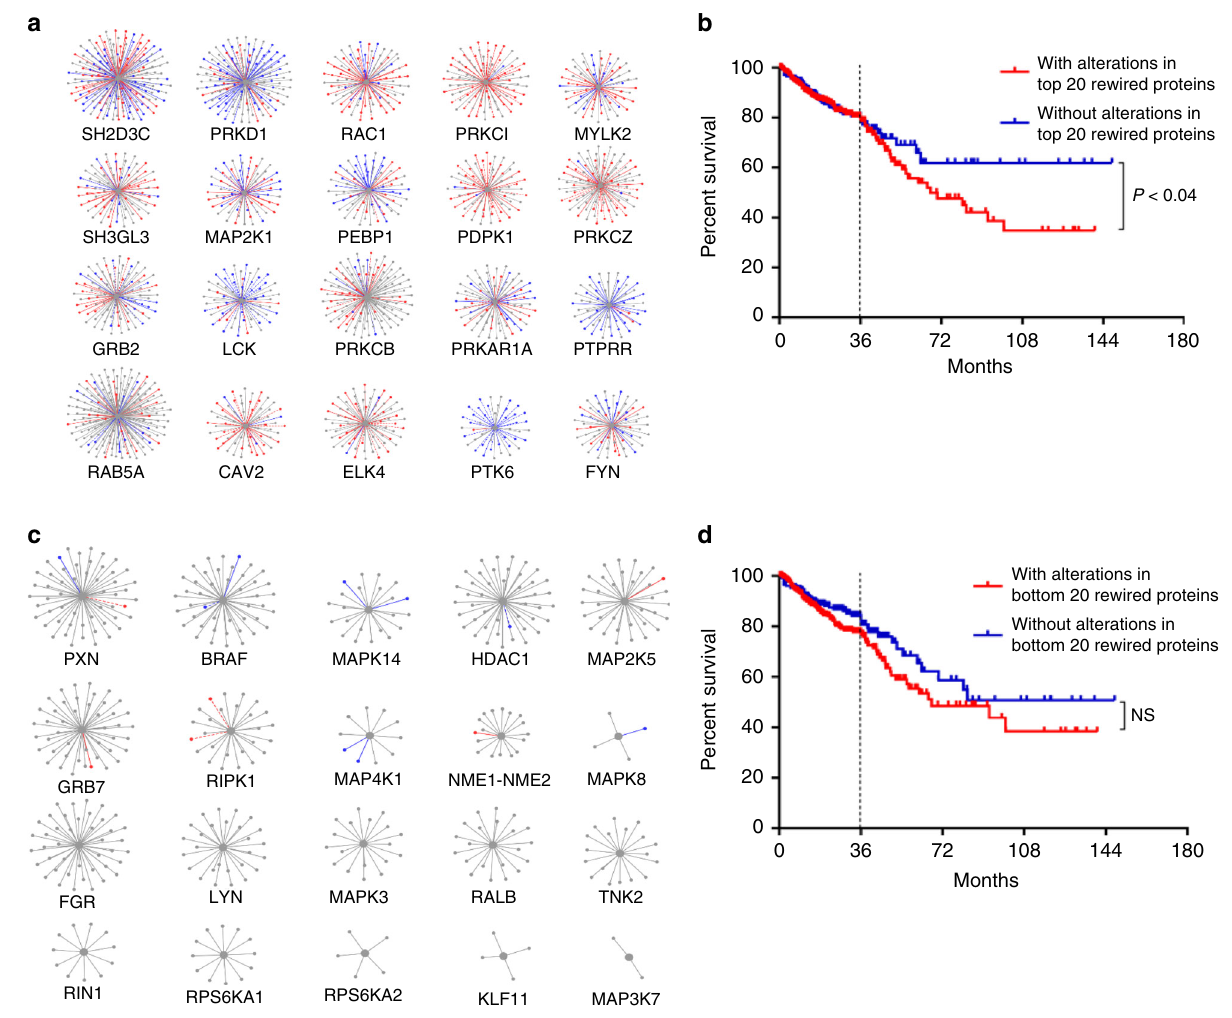
Fig. 6 PPIN rewiring and CRC prognosis. a The top 20 most rewired bait proteins. Interactions where the prey protein was identi fi ed only in EGFRNet mtKRAS-Hi or EGFRNet mtKRAS-Lo are shown as solid red or blue lines, respectively. Rewired bait-prey interactions where prey abundance was signi fi cantly higher in EGFRNet mtKRAS-Hi or EGFRNet mtKRAS-Lo are shown as dotted red or blue lines, respectively. Bait – prey interactions which were not signi fi cantly different are gray. b Six hundred and twenty-nine CRC patients from the TCGA were divided into two groups, those with alterations in the top 20 rewired bait proteins (339; 54%) and those without alterations in the top 20 rewired bait proteins (290; 46%). The alterations assessed were mutations, copy number changes, mRNA expression changes, and protein expression changes. Kaplan – Meier survival curves were plotted for the two patient groups using PRISM 7.0.3. Five-year survival was 53.5% for patients with genetic alterations affecting the top 20 rewired nodes compared to 68.5% for patients without alterations in these proteins, and ten-year survival was 34.61 vs. 61.43%, respectively. The log-rank test was used to assess statistical signi fi cance. c The bottom 20 least rewired bait proteins. d There was no signi fi cant (NS) difference in survival between patients with alterations in the bottom 20 least rewired bait proteins and those without. Source data are provided as a Source Data fi vector 58 with the FLAG-tag at the N-terminus using the Gateway cloning system (Thermo Fisher). sections 16 – 18, for a detailed description. AP-MS experiments . Cells were transfected with baits titrated to achieve similar expression levels between the cell lines and labeled with stable isotope (SILAC) medium (Fig. 1). Baits were immunoprecipitated with anti-FLAG-M2 conjugated agarose beads (Sigma-Aldrich A2220), digested with trypsin and analyzed by quantitative MS using a Q-Exactive mass spectrometer (Thermo Fisher Scienti fi c). Data were analyzed with MaxQuant 59 and HiQuant 19 software packages. See Supplementary Methods, sections 8 – 12, for a detailed description.